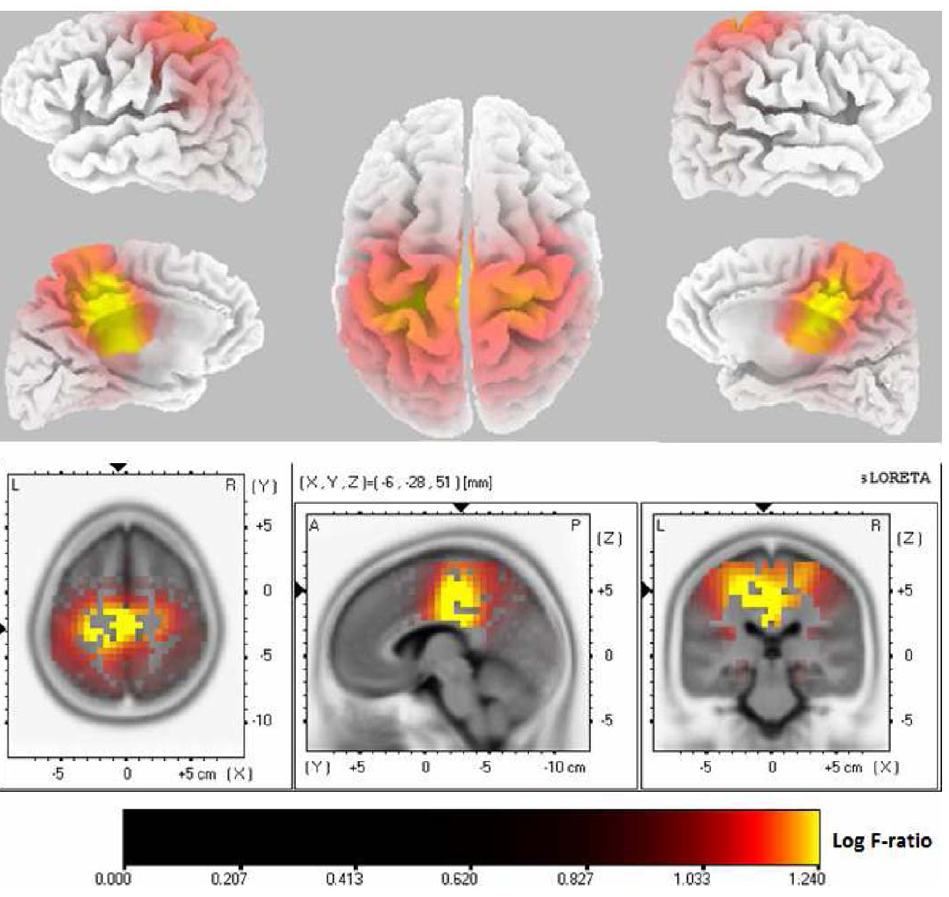
Figure 2. eLORETA statistical maps of theta oscillations. Colored areas represent the spatial extent of voxels with significant difference (red- coded for p , 0.05; yellow-coded for p , 0.01, corrected for multiple testing) in source current density in psychotic vs. nonpsychotic epilepsy patients. Significant results are projected onto a fiducial cortical surface (top panel) and a brain MRI template (bottom panel). The MRI slices are located at the MNI-space coordinates indicated in the figure that correspond to the voxel of highest significance (i.e., left posterior cingulate/precuneus cortex). The color scale represents log F-ratio values (threshold: log-F=1.03, p , 0.05). L, left; R, right; A, anterior; P, posterior.